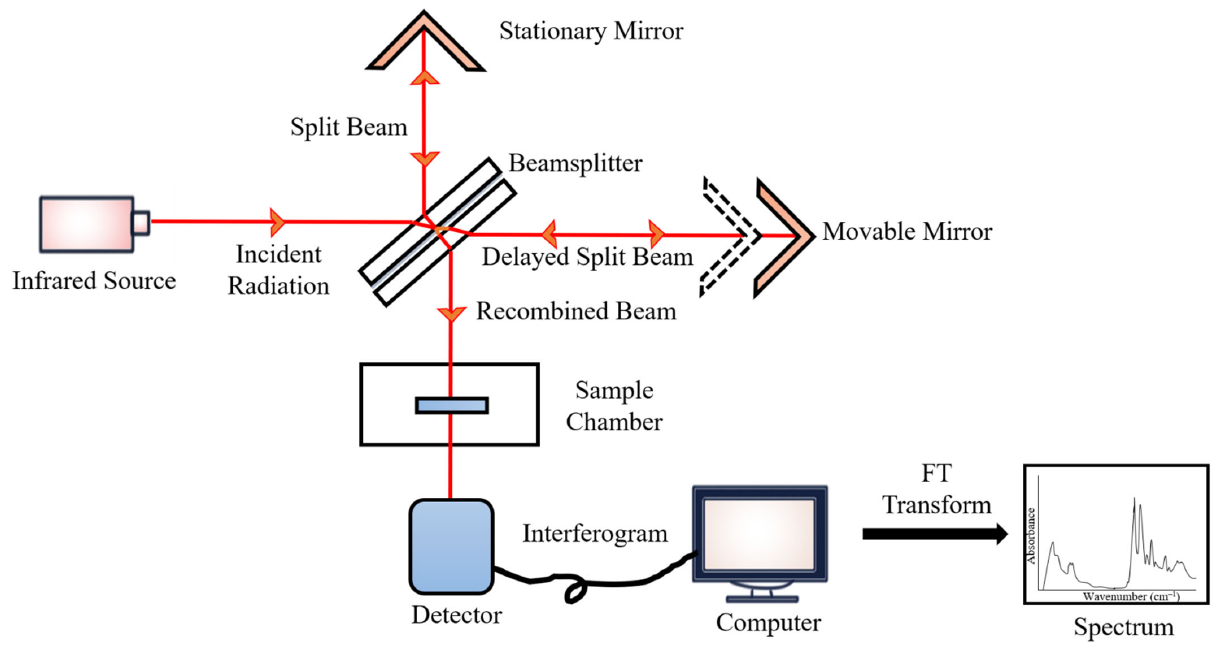
Figure 2. FTIR block diagram.